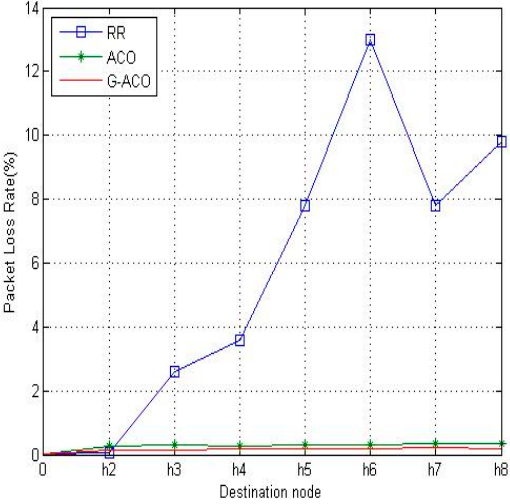
Figure 10. The comparison of packet loss rates.